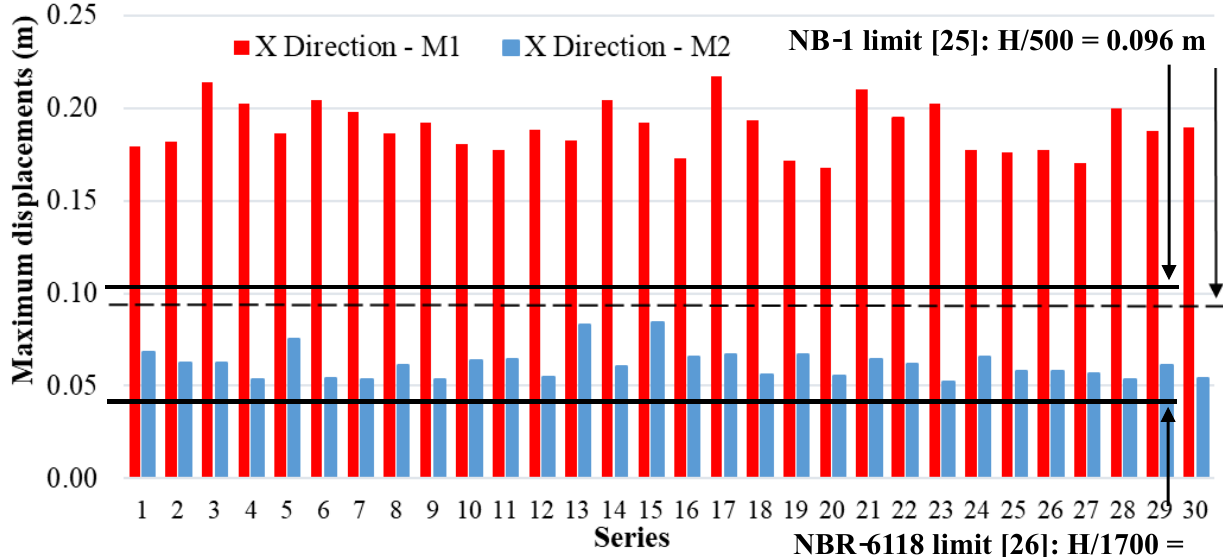
NBR-6118 limit [26]: H/1700 = 0.028